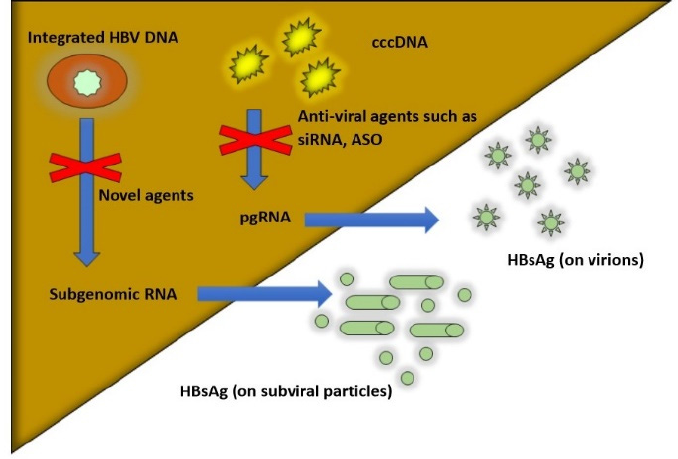
Figure 1. Different Sources of Hepatitis B s antigen (HBsAg) in the body. Red crosses show various pathways that are inhibited by different antiviral medications.